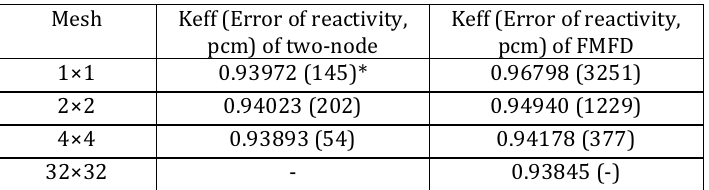
Table I. Keff Comparison of 2D 4G Benchmark Problem